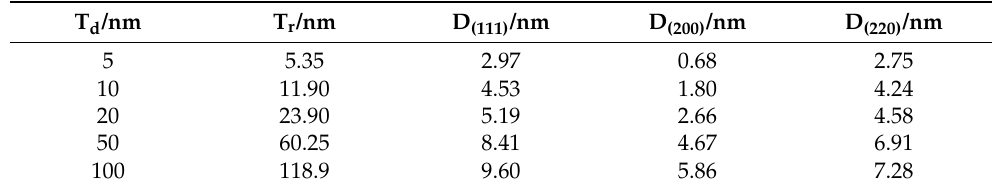
Table 2. Real average layer thickness (T r ) and grain size in different orientations (D (hkl) , D = D (111) ) of amorphous ZrC/nanocrystalline Ni multilayers.